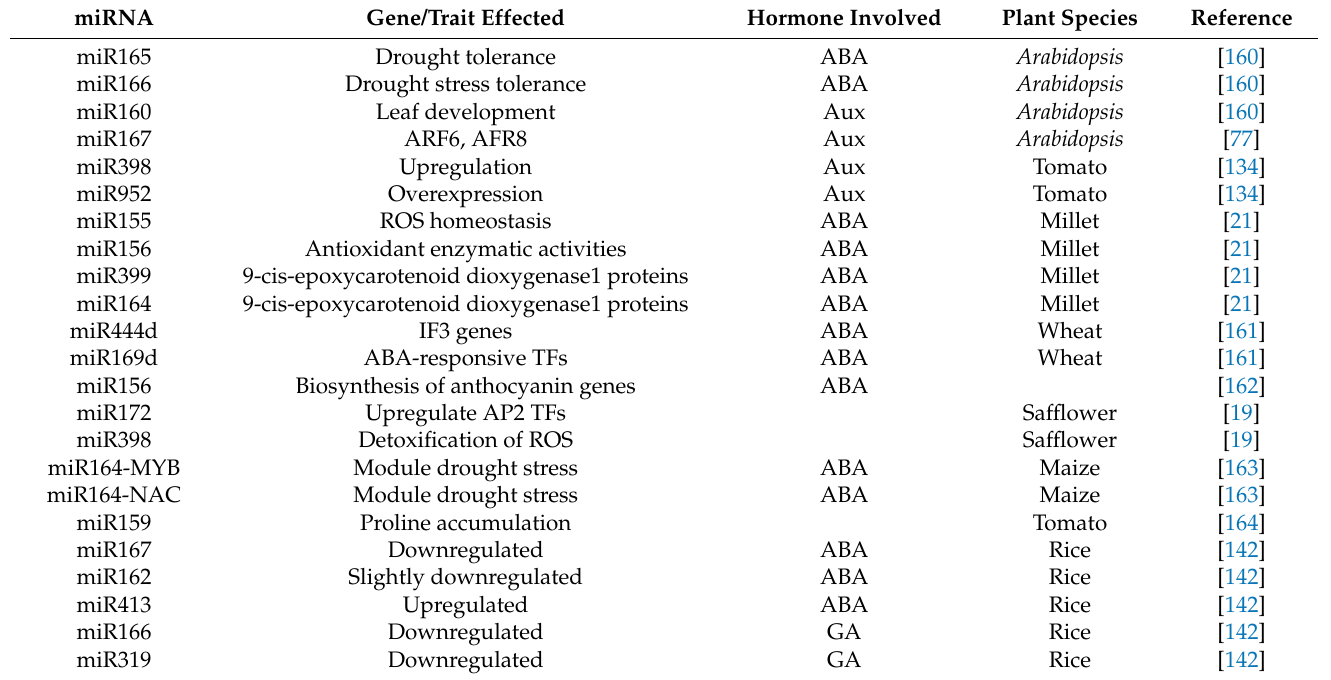
Table 2. miRNAs response to drought stress via phytohormonal